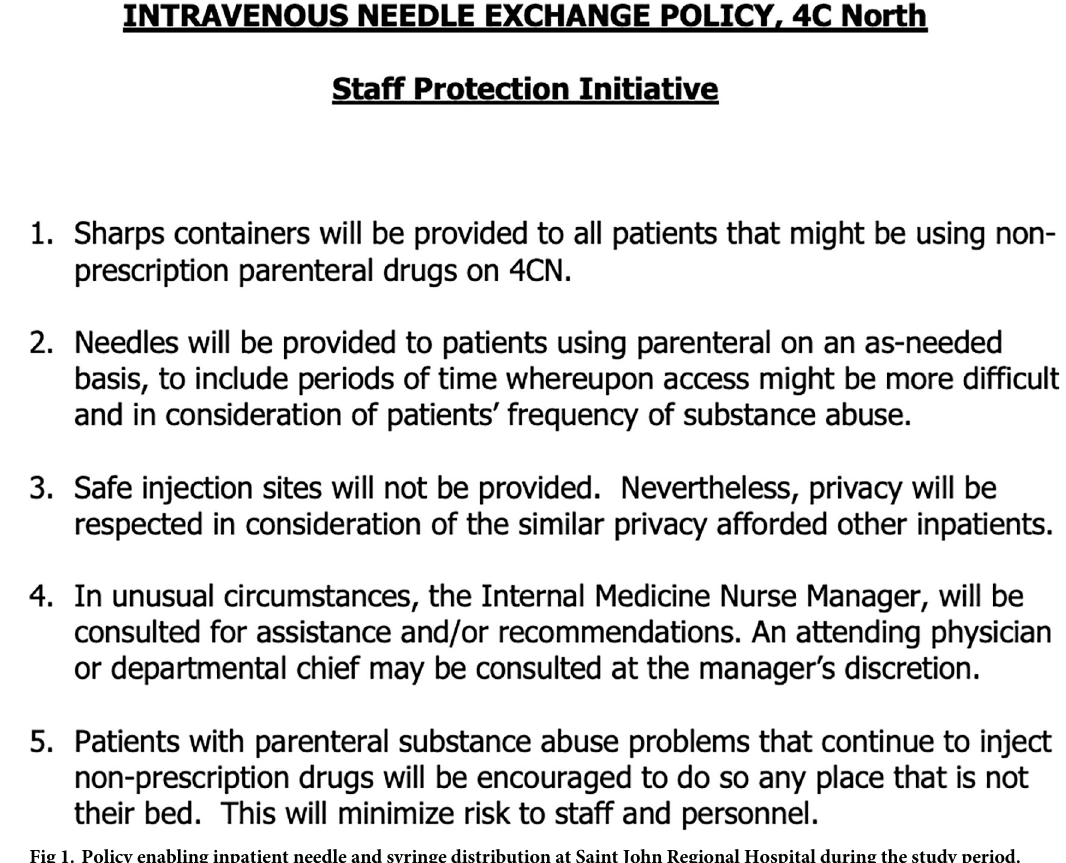
Fig 1. Policy enabling inpatient needle and syringe distribution at Saint John Regional Hospital during the study